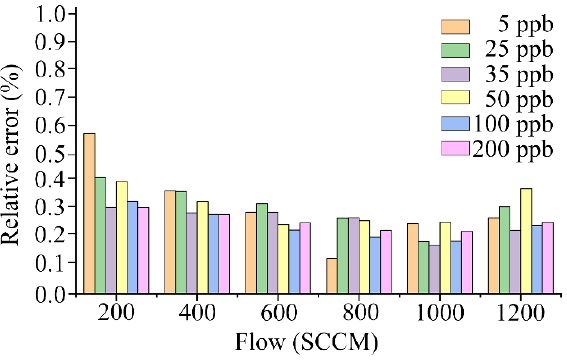
Figure 9. Relative errors of electronic nose system.